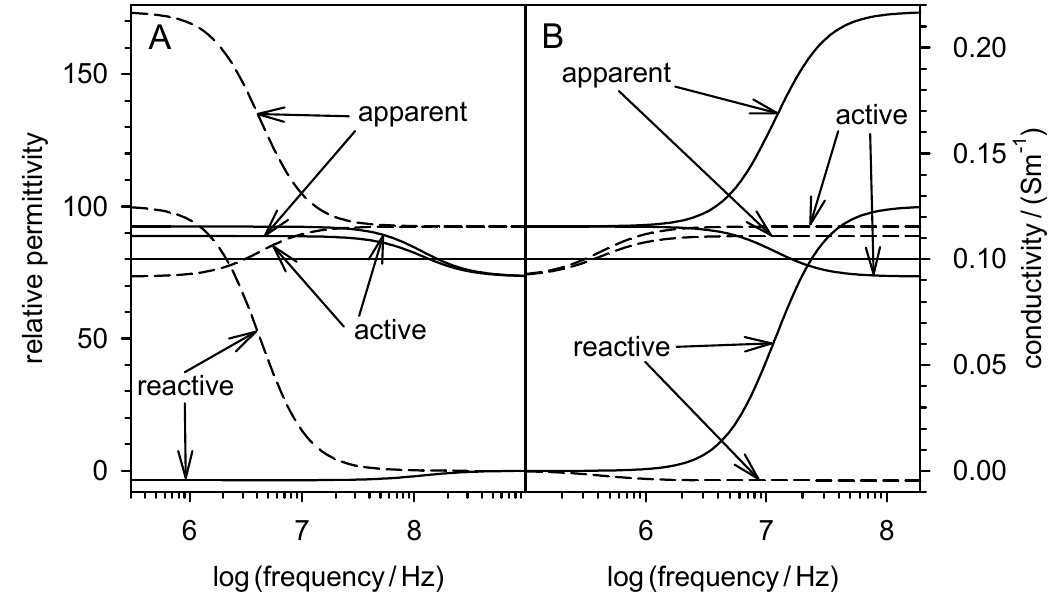
Figure 5. Component plots of the real parts of the relative permittivity (( A ); Equation (18)) and conductivity (( B ); Equation (35)) of two suspensions containing a single homogeneous sphere (Dashed lines: σ i = 0.01 S/m, ε i = 800; solid lines: σ i = 1 S/m, ε i = 8). The apparent permittivity and conductivity are the sums of their active and reactive components.